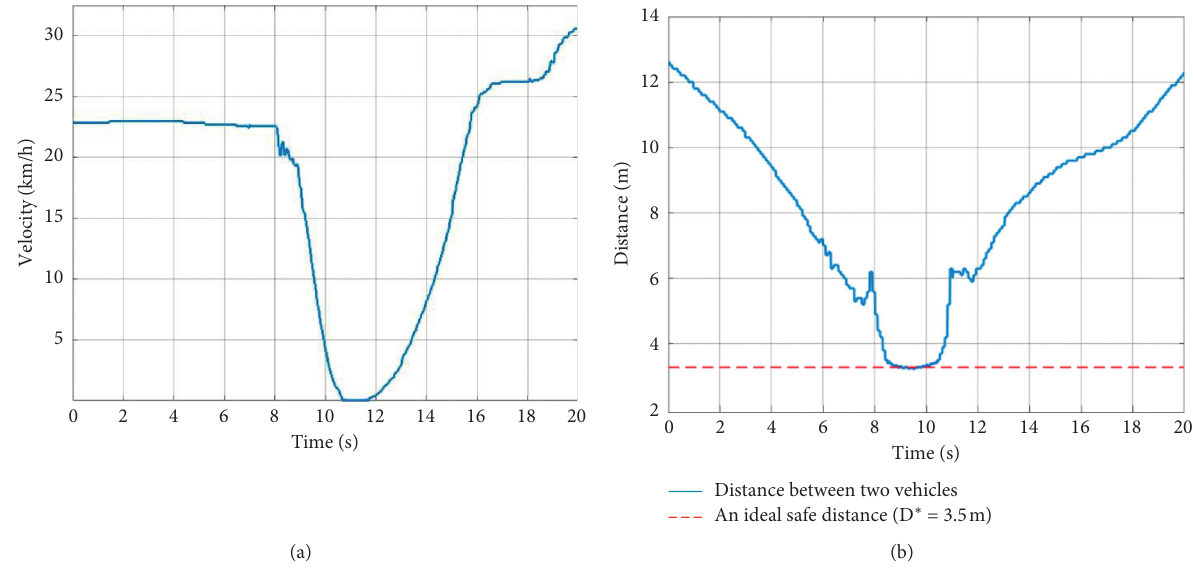
Figure 14: The real vehicle automatic stop-and-go task under the urban overpass driving condition. (a) The host vehicle’s velocity. (b) The distance between two